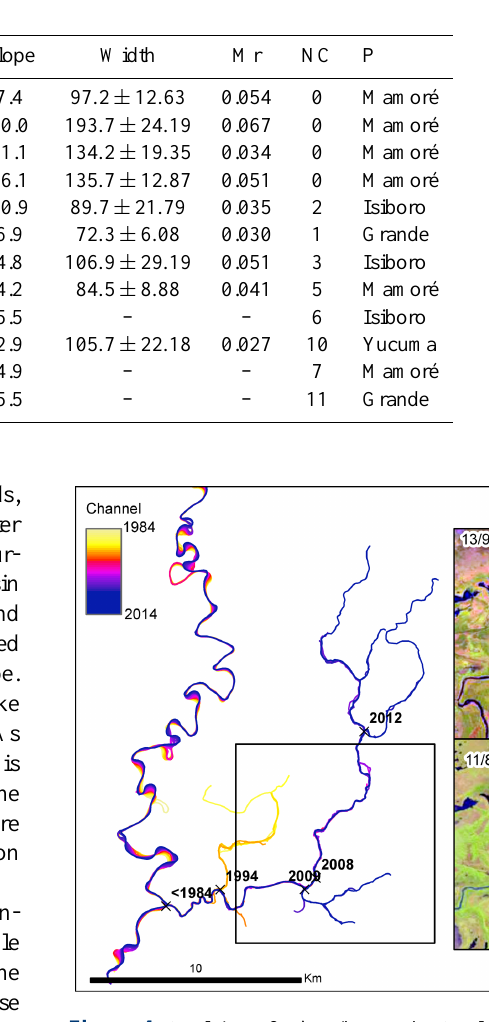
Table 3. River characteristics. Catch is the Andean catchment in km 2 ; Sin is the sinuosity measured along the meandering part of the river calculated as the ratio of channel centreline length to the sum of the channel-belt axis lengths, Río Grande and Piraí do not have a long enough meandering reach to allow the measurement; D is the sum of the channel-belt axis lengths from the point at which the river exits the Andes to the point where it reaches its parent river, expressed in kilometre; Slope is the average slope along the river measured as the ratio of the difference in elevation between the point at which the river exits the Andes to the point where it reaches its parent river and D , multiplied by 10; Width is the channel width measured along straight sections of the channel, expressed in meters ± 1 standard deviation; Mr is the average meander migration rate normalized for the channel width, expressed as channel widths per year (ch − wyr − 1 ) (Constantine et al., 2014); NC is the number of crevasses; P is the parent river.